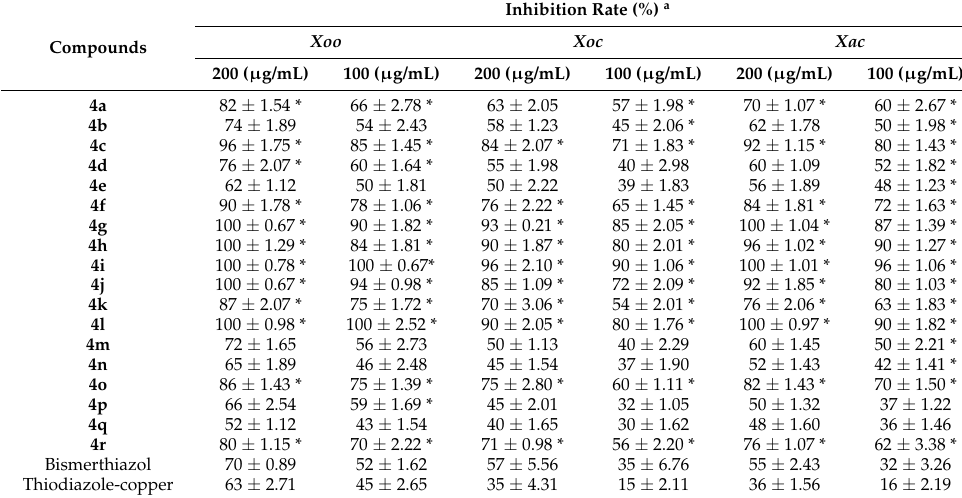
Table 1. In vitro antibacterial activities of the target compounds 4a – 4r against Xanthomonas oryzae pv. oryzae , Xanthomonas oryzae pv. oryzicolaby , and Xanthomonas axonopodis pv. citri at 200 and 100 µ g/mL.